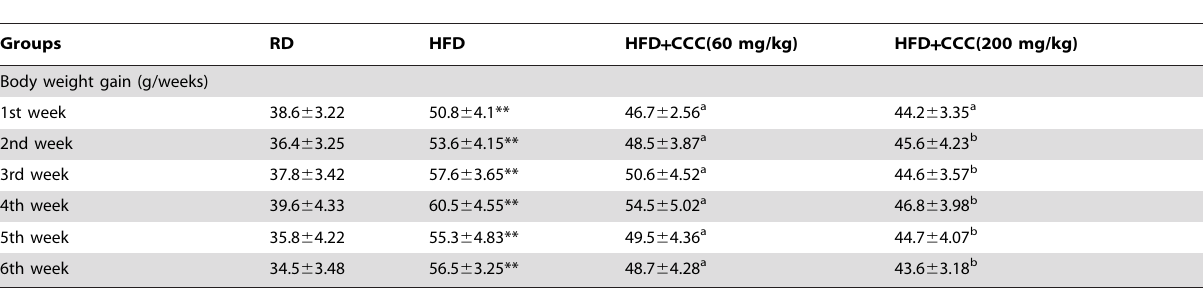
Table 2. Effects of CCC extracts on the body weight of HFD-induced obese rats.